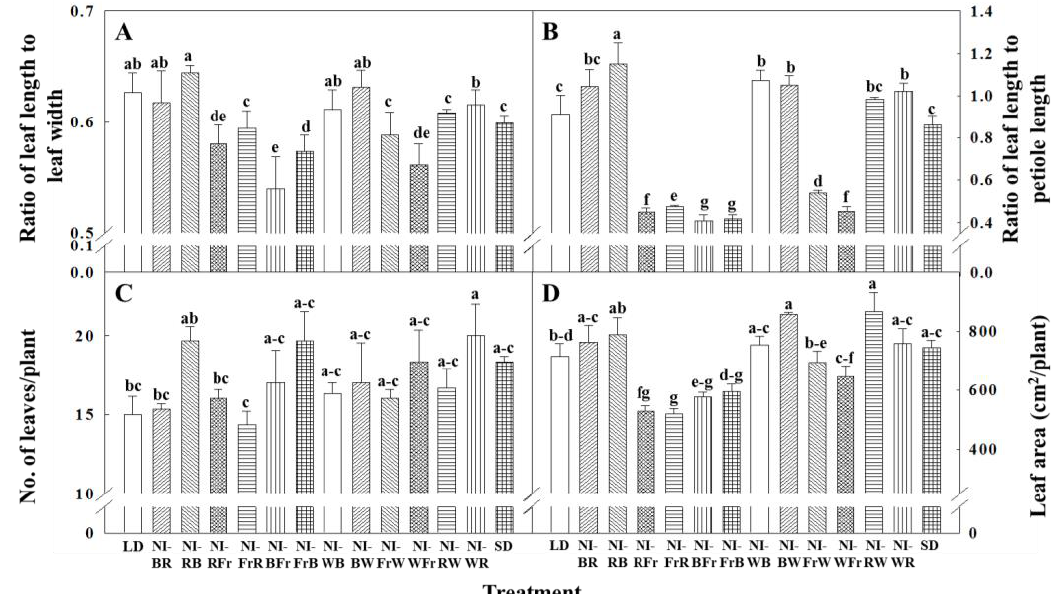
Figure 3. Effects of 10 μmol·m −2 ·s −1 PPFD night-interruption light (NIL) quality shifting on the leaf length to width ratio ( A ), leaf length to petiole length ratio ( B ), number of leaves per plant ( C ), and leaf area ( D ) of geranium ( Pelargonium × hortorum L.H. Bailey ‘Ringo 2000 Violet’) measured 40 days after treatment. Please refer to Figure 1 for detailed NIL qualities. Vertical bars are means ± S.E. (n = 3). Means accompanied by different letters are significantly different ( p < 0.05) according to Duncan’s multiple range test at 5% significance level.